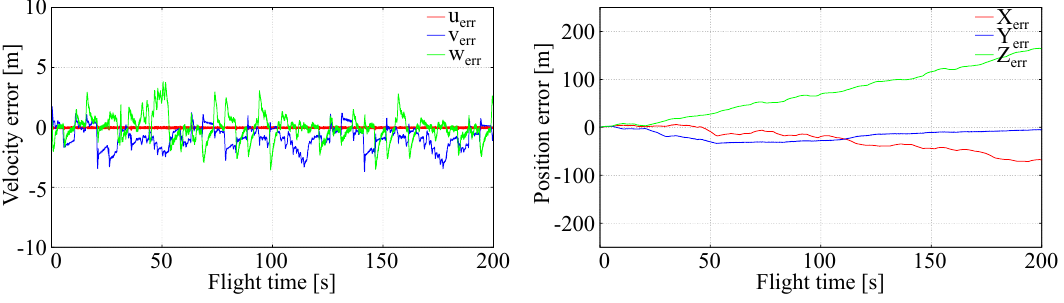
Figure 7. Full tracking in turbulent conditions.